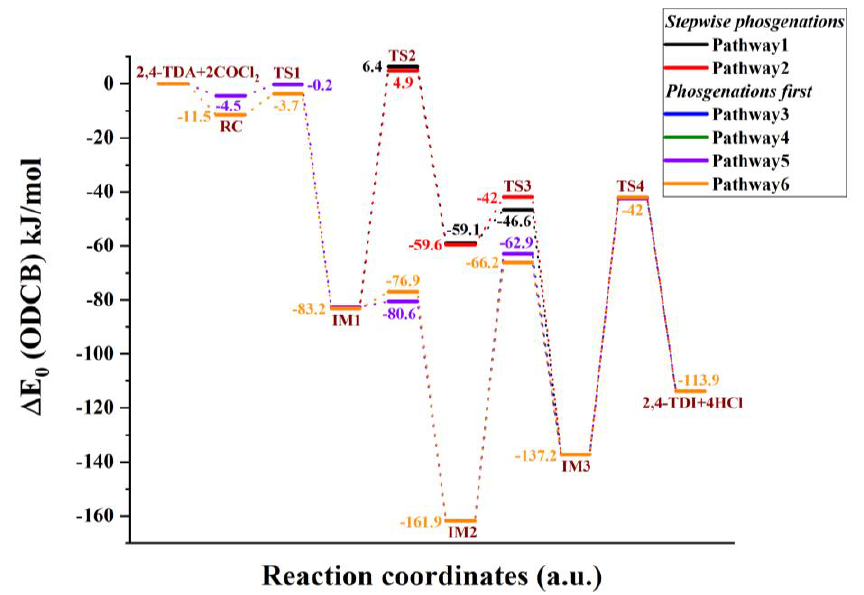
Figure 4. G3MP2B3 energy profile (zero-point corrected) for the phosgenation of 2,4-TDA in ortho- dichlorobenzene (ODCB).